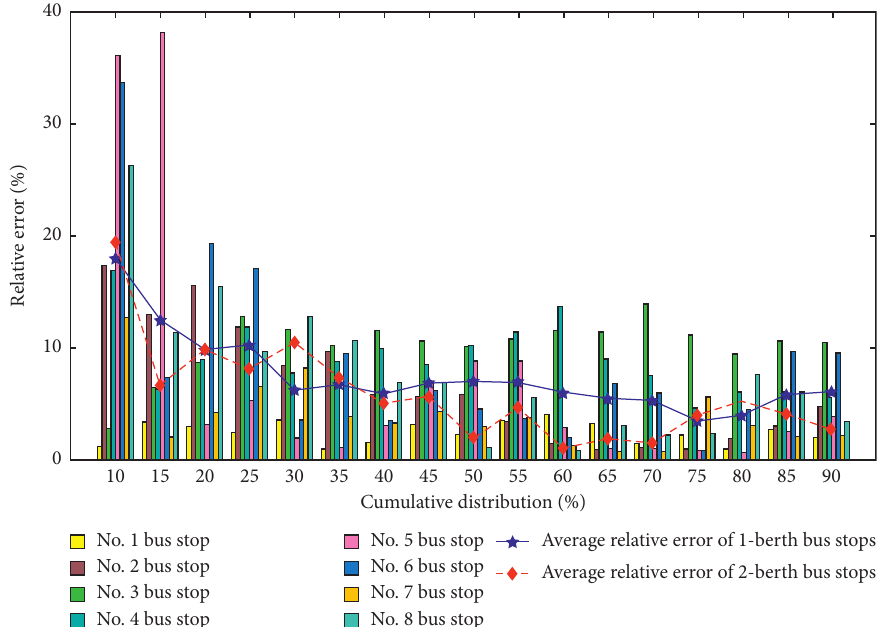
Figure 14: Comparison of FDR estimation relative error at CDF